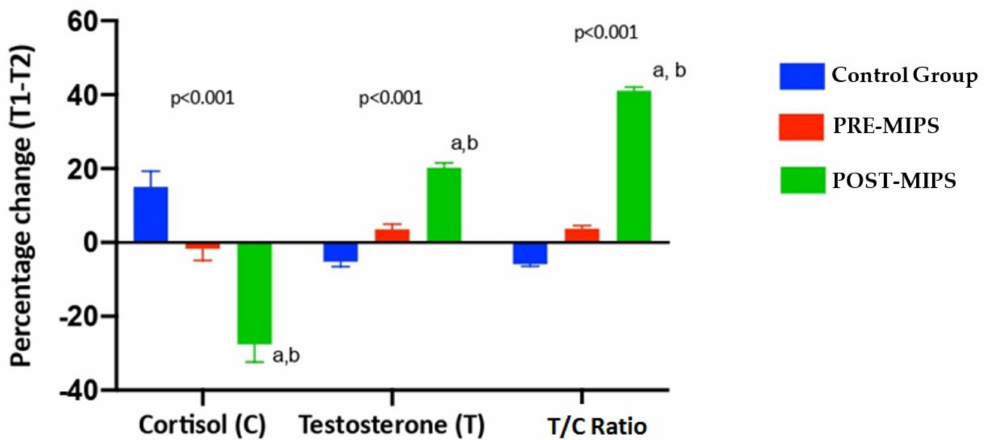
Figure 2. Percentage change in muscle recovery parameters between T1-T2. The data are expressed as a mean ± standard deviation. ∆ (T1-T2) (%) = ((T2T1)/T1) × 100. T1: Before the start of the race; T2: After 10 weeks of treatment. p : Group differences obtained through a 1-factor ANOVA. a : Significant differences from the Control group ( p < 0.05). b : Significant differences from the PRE-MIPS ( p < 0.05).